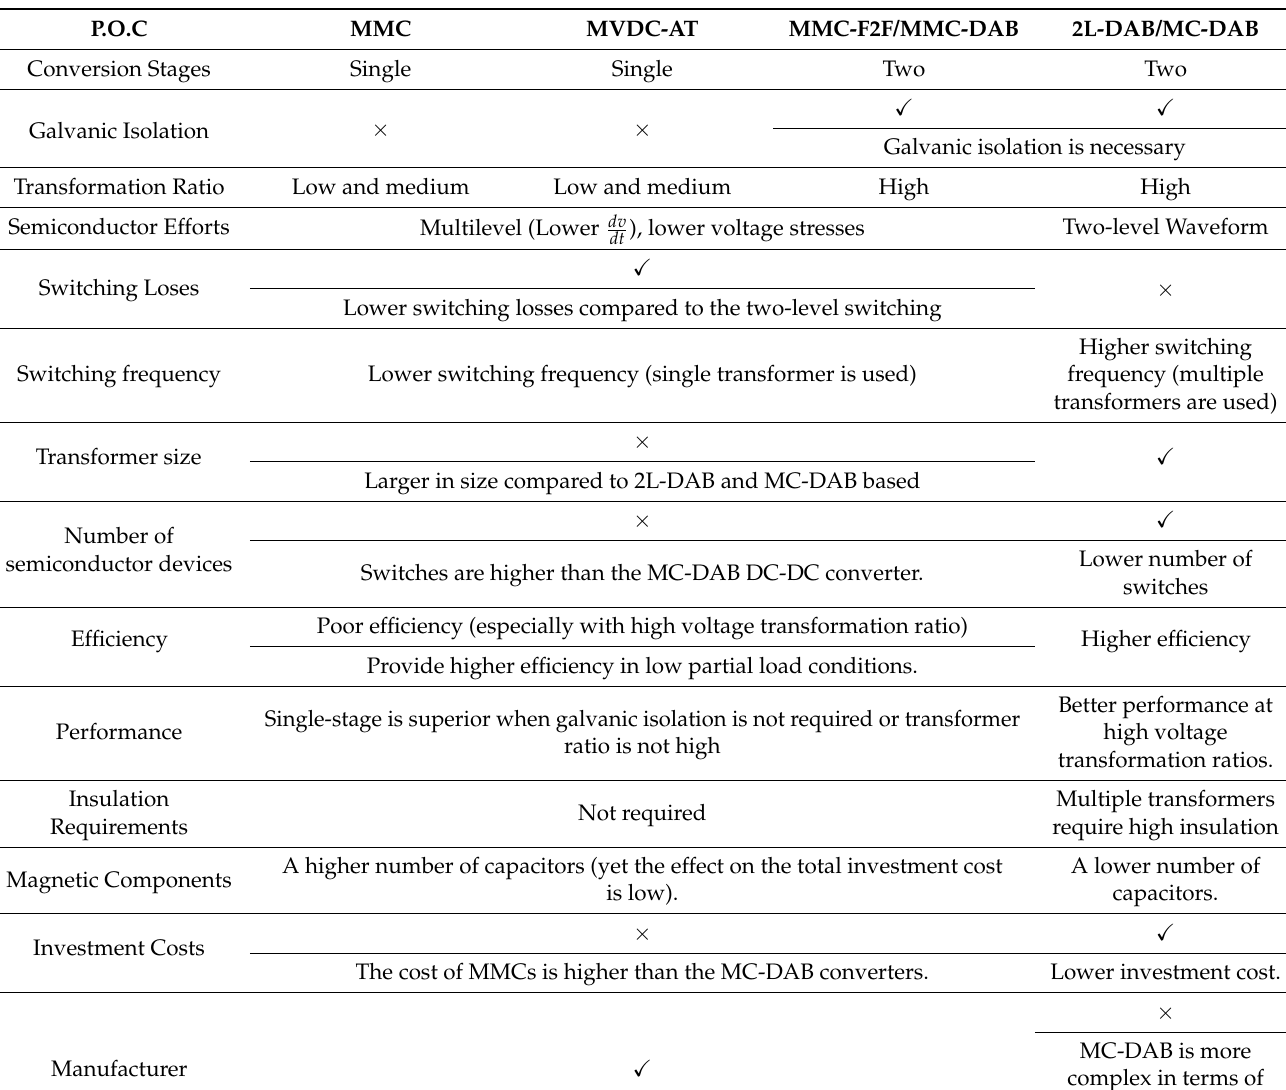
Table 2. Comparison between MCC topologies and multimodule two-level DC-DC